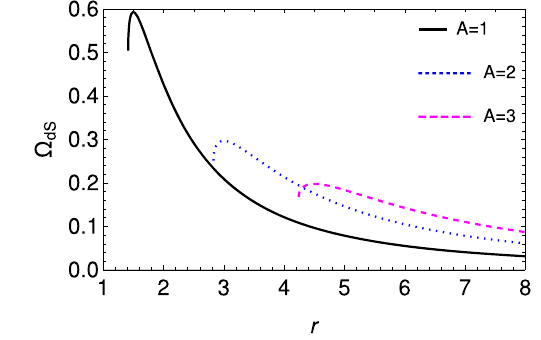
Fig. 3 Variation of geodetic precession (cid:3) dS (unit of ‘length − 1 ’) ver- sus r (unit of ‘length’) for the non-rotating acoustic blacks hole with different A values. It shows that the precession frequency (cid:3) dS initially increases, achieves a peak value and then decreases (until it reaches to √ the orbit of radius r = 2 A ), as the gyro approaches the